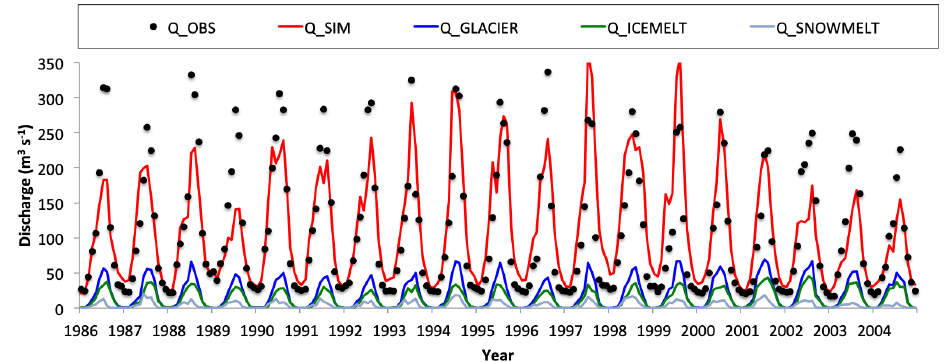
Figure 5. The monthly observed (Q_OBS) and simulated discharge (Q_SIM), including the total discharge from glacier (Q_GLACIER), ice melting (Q_ICEMELT), and snowmelting discharge (Q_SNOWMELT) in the upper Beas basin during 1986–2004.